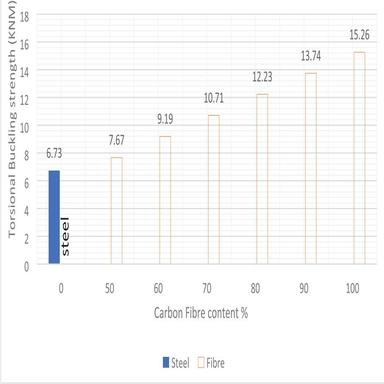
Torsional buckling strength of steel and composite drive shaft.